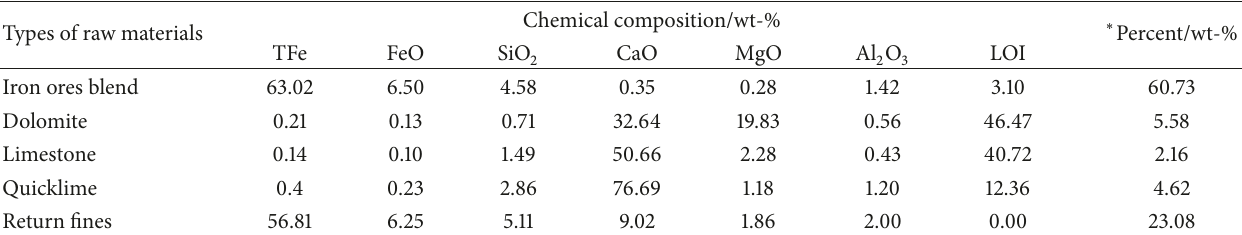
Table 1: Chemical compositions of raw materials and their proportions in mixture.